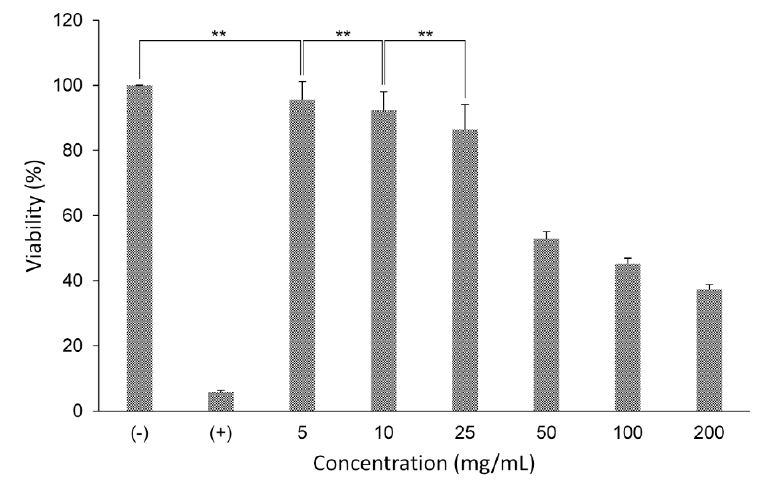
Figure 8. Viability of 3T3 cells after incubation with different CS crystal concentrations: 5, 10, 25, 50, 100, and 200 mg/mL, ( − ) negative control and (+) positive control. Error bars represent mean ± SD. Statistically significant difference each other (* p < 0.05; ** p < 0.01)